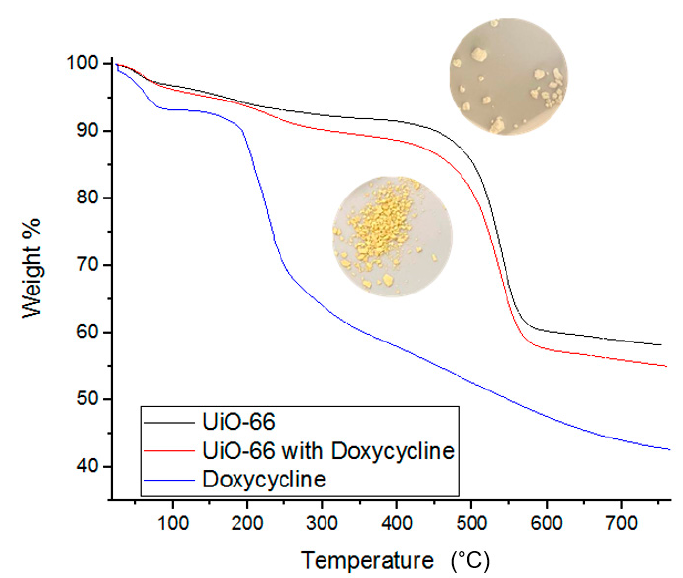
Figure 8. TGA data for fresh UiO-66, fresh Doxycycline, and Doxycycline-filled UiO-66. Images of Doxycycline loaded (bottom) and unloaded UiO-66 (top) are provided.